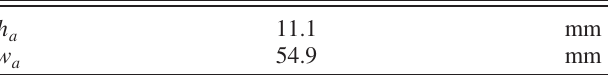
TABLE II. Optimal dimensions of the PM blocks, assuming